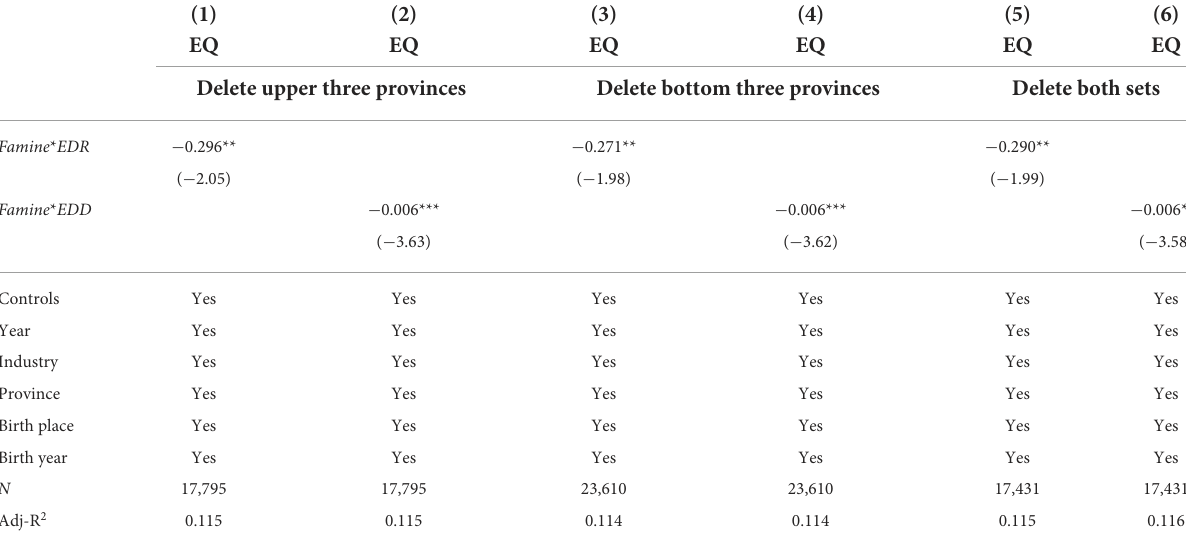
TABLE 9 CEOs’ famine experience and the quality of corporate earnings—the impact of excluding CEO samples.